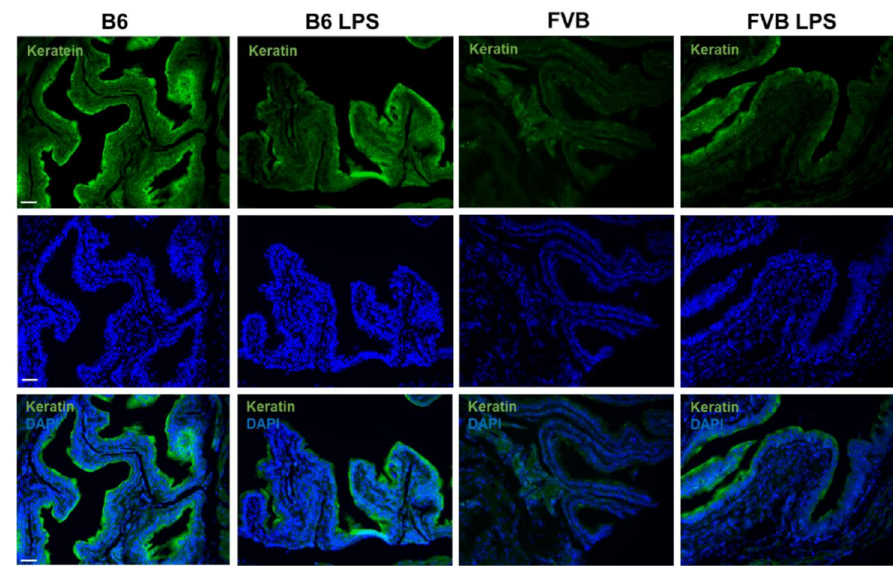
Figure 9. Keratin-5-stained cytoplasmic intermediate filament proteins (green, first row) expressed on the bladder epithelial tissues of the B6-ctrl, B6-LPS, FVB-ctrl, and FVB-LPS mice. DAPI-stained and the keratin 5-DAPI merged images for each group are shown in the second and third row, respectively. All images were taken at 100 × magnification (Scale bar = 50 µ